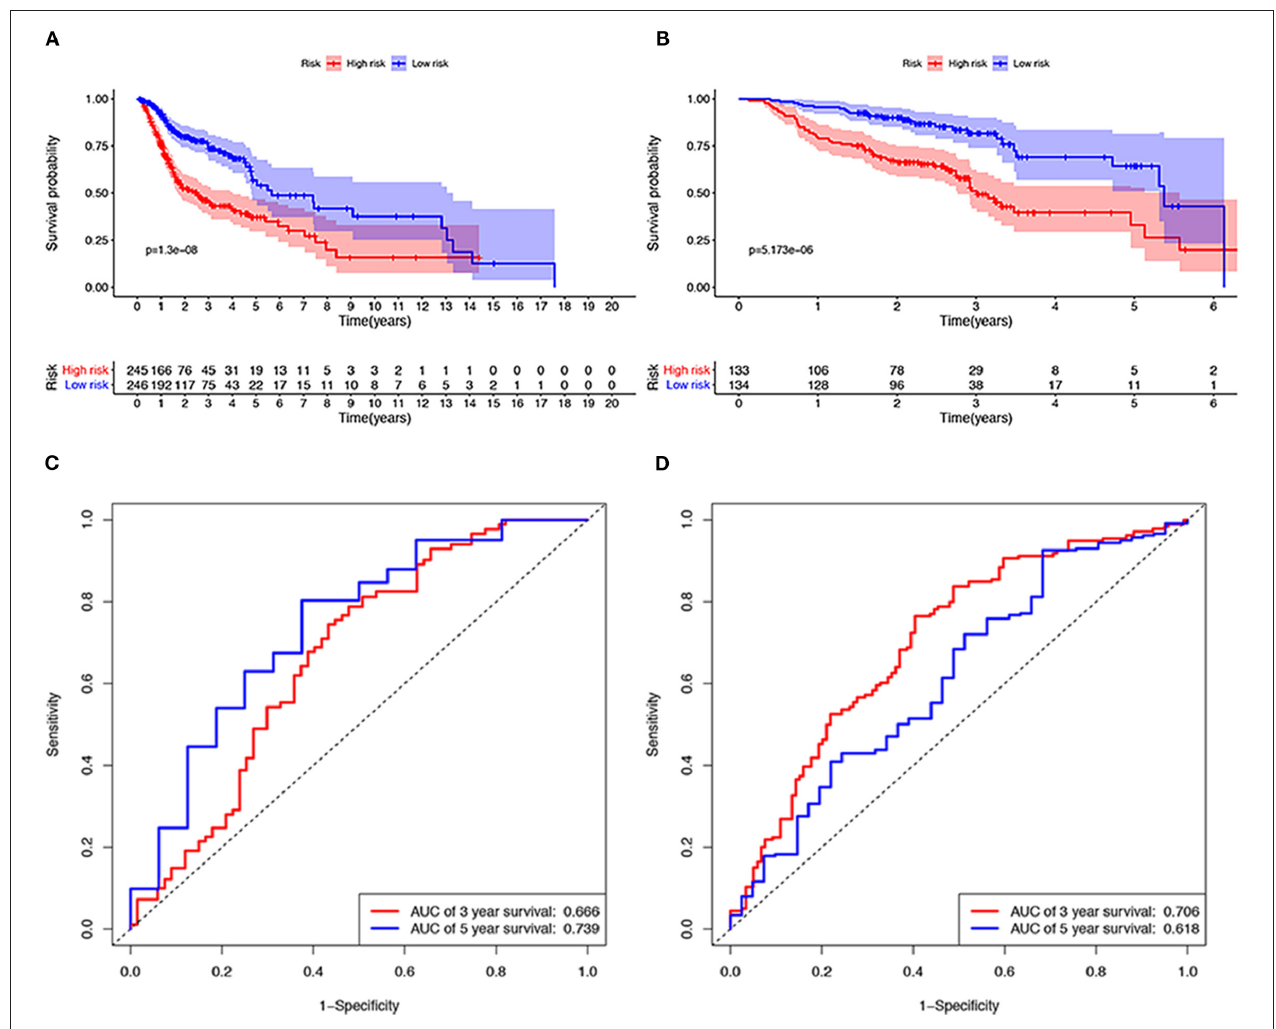
FIGURE 4 | Verification of the seven gene signatures in training and validation cohort. Kaplan–Meier analysis shows that patients with high risk scores have poorer OS, whether in the TCGA ( A ) or the GSE65858 data set (B) . The ROC curve shows the accuracy of predicting the 3-year and 5-year OS of patients in the TCGA (C) and GSE65858 data sets (D)